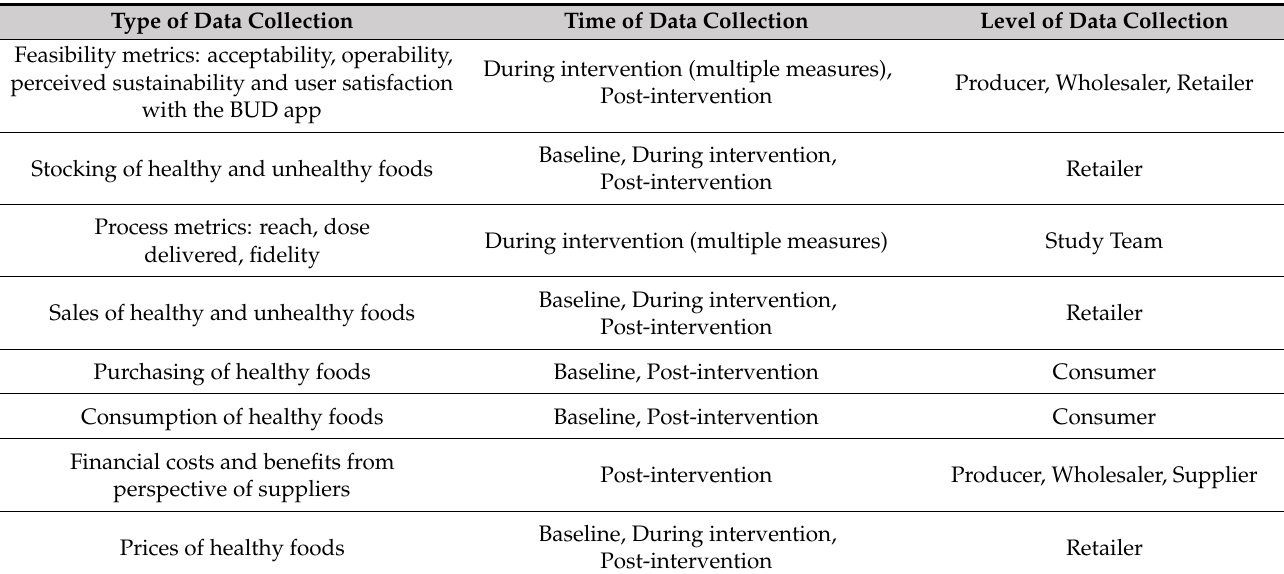
Table 2. Summary of impact and process measures by level of data